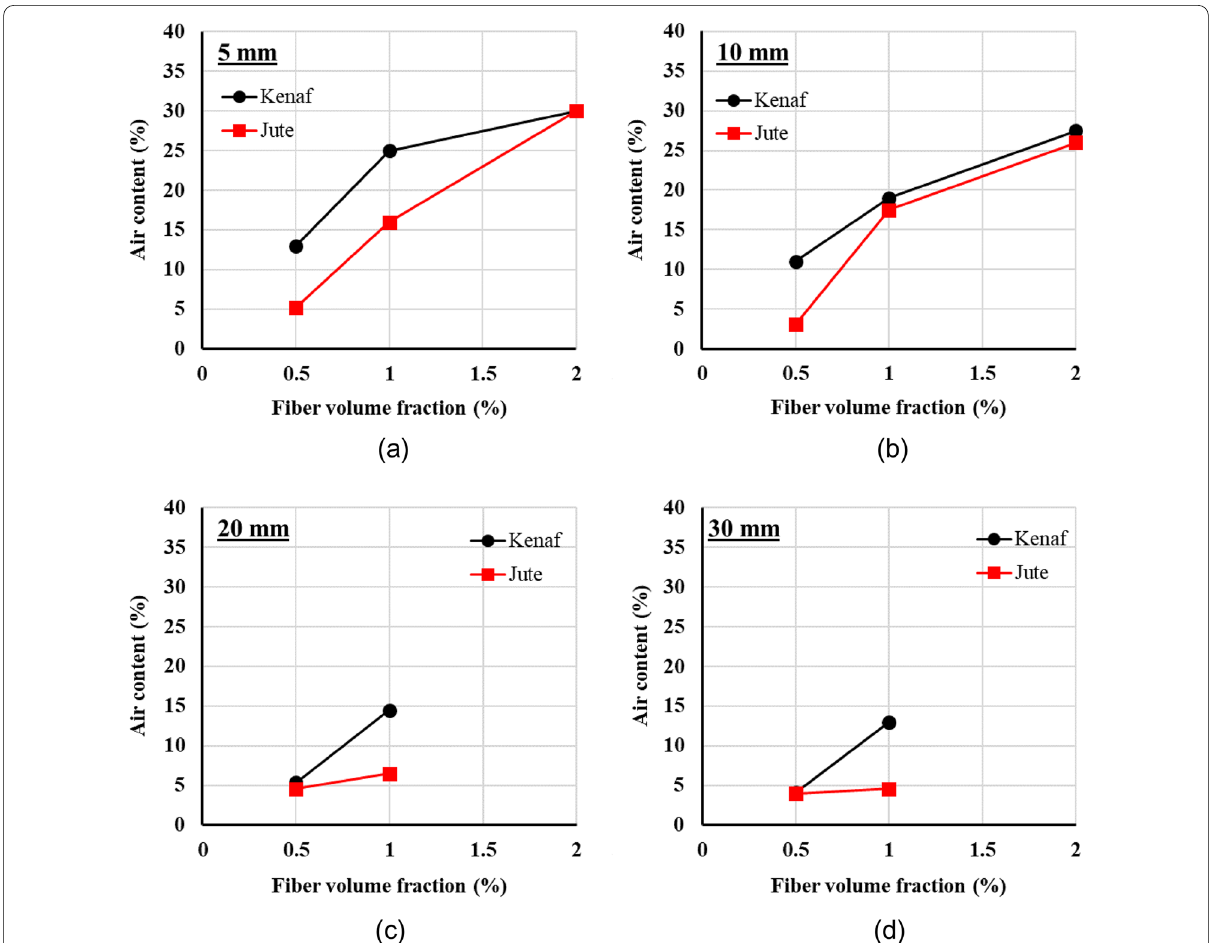
Fig. 12 Air content of NFRCCs versus the volume fraction of fibers of different lengths: a 5 mm; b 10 mm; c 20 mm; d 30